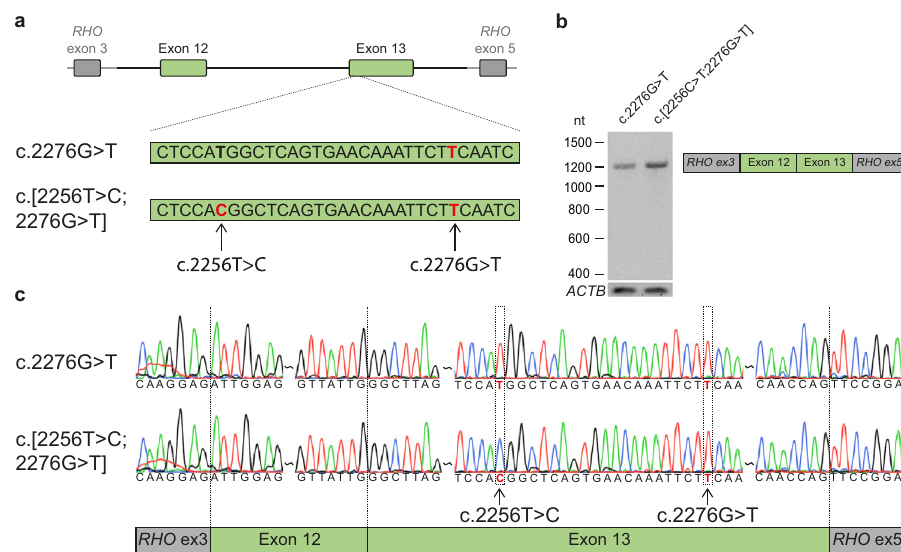
Fig. 1 Minigene splice assays for variants c.2256 C > T and c.2276 G > T. a A minigene splice assay was performed with a construct spanning from USH2A intron 11 to intron 13 (6,814 nt), containing either c.2276 G > T or both variants (c.[2256 T > C;2276 G > T]). b A single RT-PCR product of 1112 nt was observed after expression of both splice vectors, indicative of the incorporation of USH2A exons 12 and 13 between RHO exons 3 and 5 in both transcripts. c Sanger sequencing con fi rmed that USH2A exon 12 and exon 13 were correctly incorporated in the